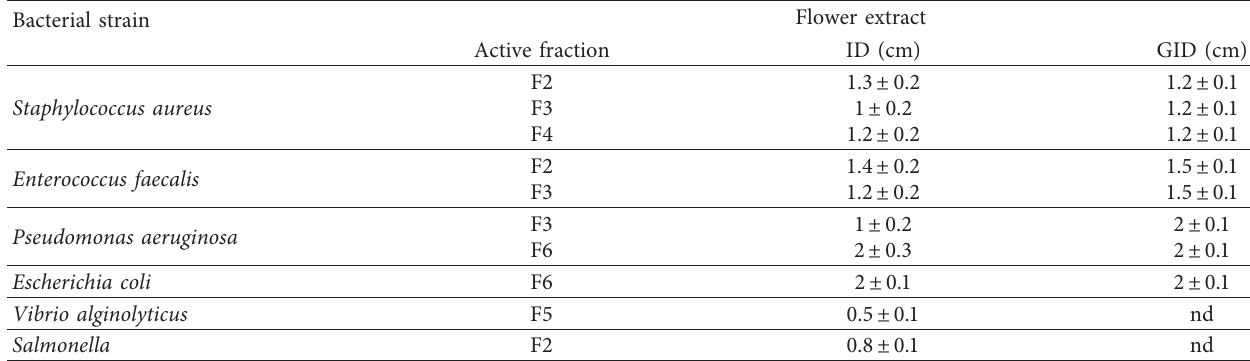
Table 5: Antibacterial